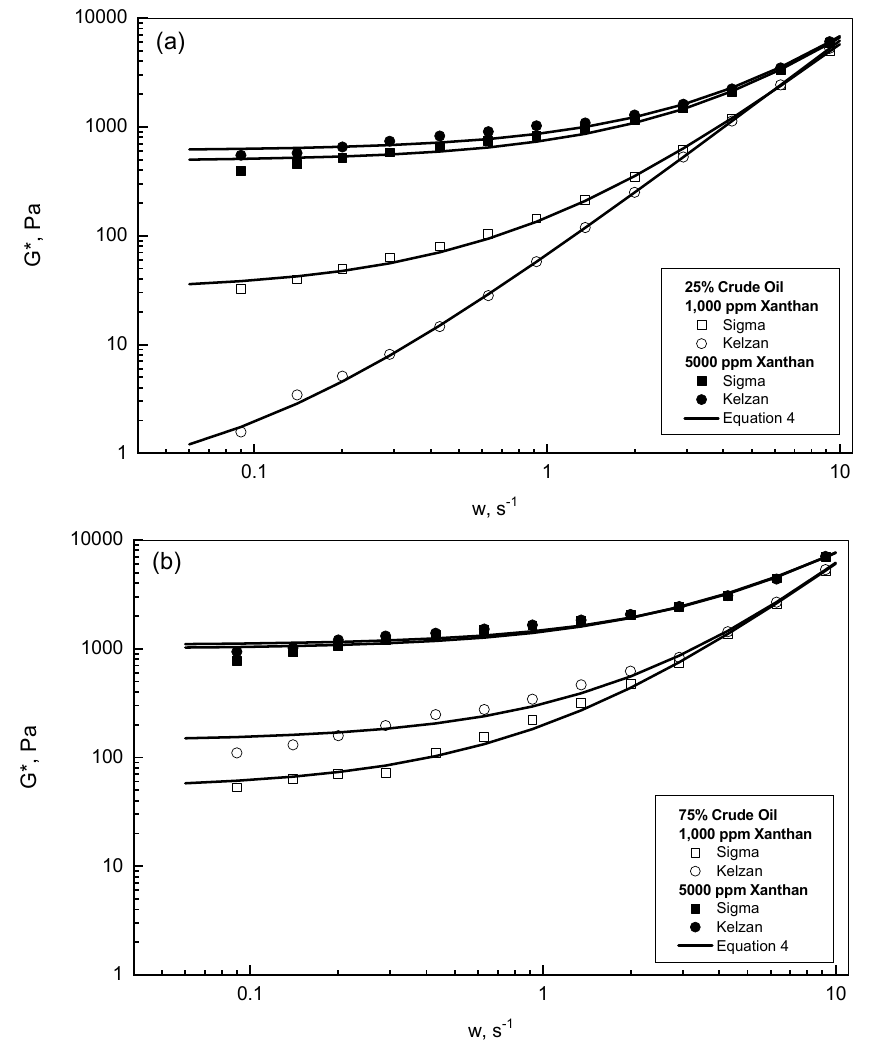
Figure 4. G* behavior of Sigma and Kelzan emulsions. ( a ) 25% crude oil emulsions; ( b ) 75% crude oil emulsions.